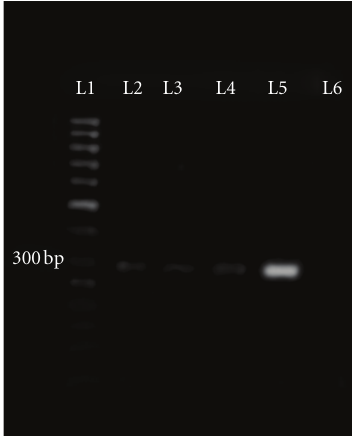
Figure 2: Results of the PCR assay. Amplifying 276-bp segment of 3 (cid:2) UTR gene of IBV. Lane L1: DNA marker (50-bp), L5: positive control (RNA of the challenged IB virus), L6: negative control (RNA of negative chicken), L2, L3, L4, and L5: positive samples.